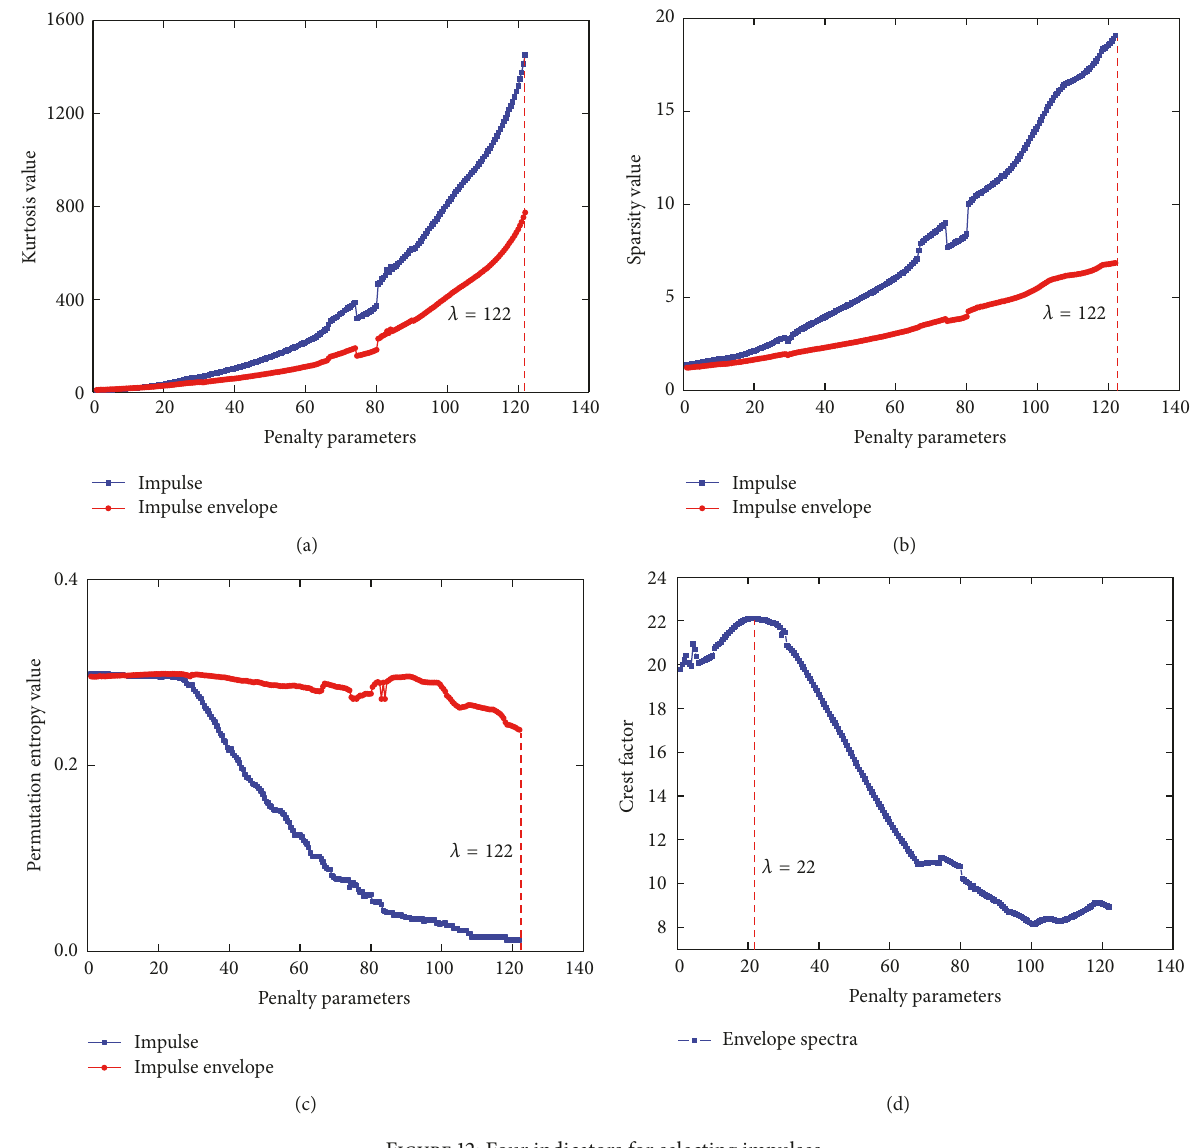
Figure 12: Four indicators for selecting